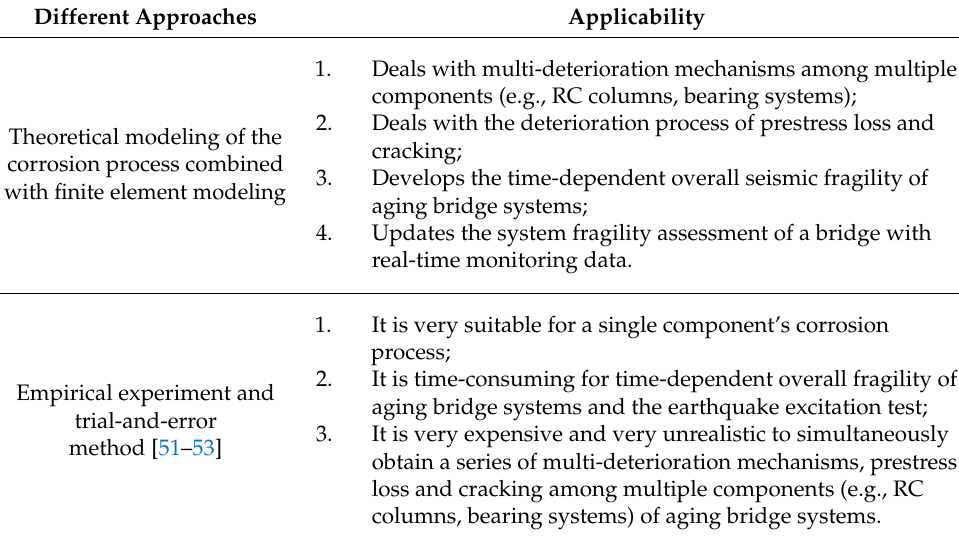
Table 7. Applicability of different